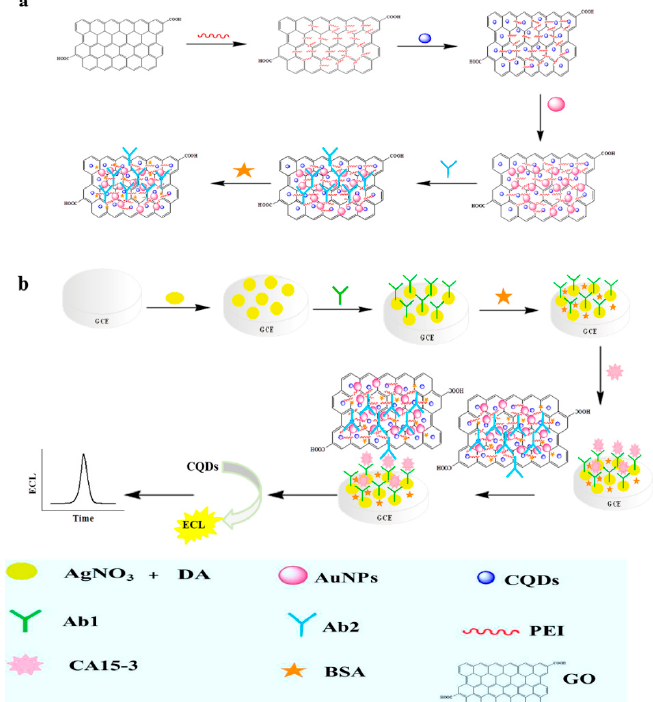
Figure 11. ( a ) Immobilization of AuNPs, CQDs, and Ab2 on the polyethylenimine-GO (PEI-GO) Matrix. ( b ) Fabrication Process of Proposed electrochemiluminescence (ECL) Immunosensor. Reproduced with permission from [84].